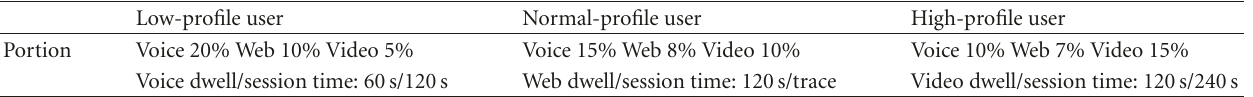
Table 2: Characteristics of QoS di ff erentiated